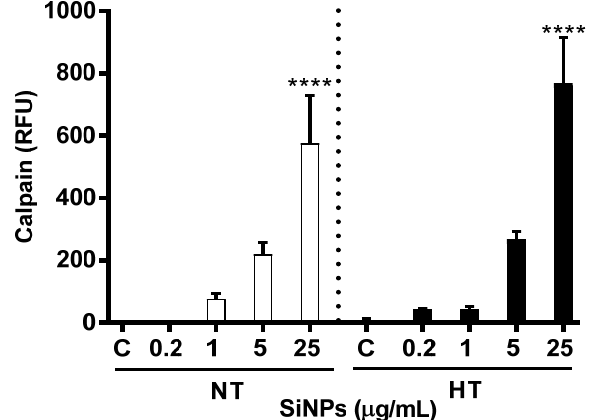
Figure 10. Effect of various concentrations ( µ g/mL) of silica nanoparticles (SiNPs) on calpain activity measured in incubated erythrocytes of normotensive (NT) and hypertensive (HT) rats. Data are mean ± SEM ( n = 6 in each group). Statistical analysis by one-way analysis of variance (ANOVA) followed by the Holm–Sidak multiple comparisons test. **** p < 0.0001 vs. respective control.